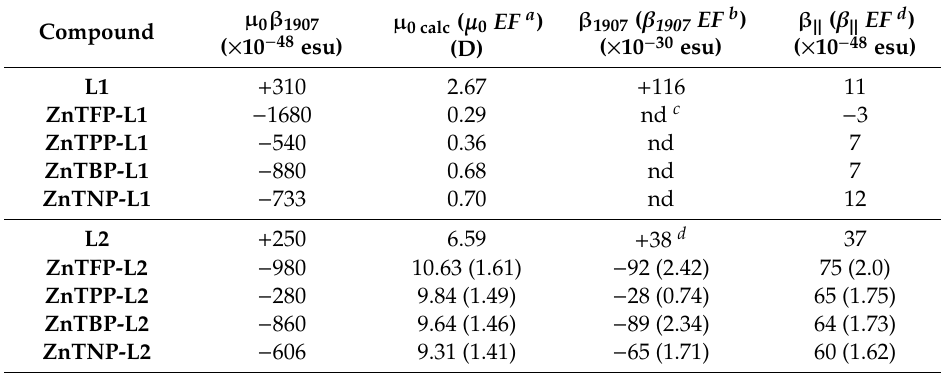
Table 2. Experimental Electric-Field-Induced Second Harmonic generation (EFISH) µ 0 β 1907 values (10 − 3 M solution in CHCl 3 ), and theoretical µ 0 and β || values of ligands L1 and L2 and of the axially coordinated A 4 Zn II